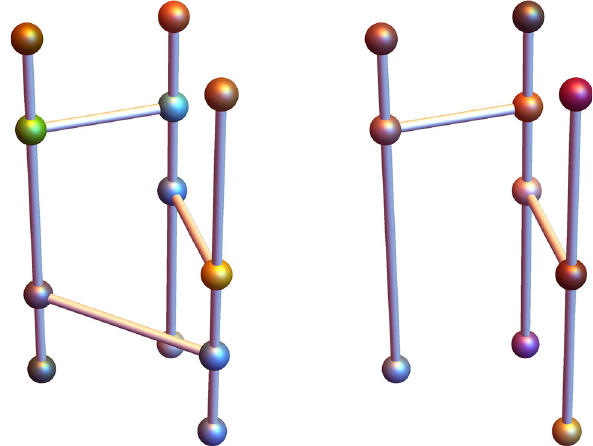
Fig. 3 A closed spin chain diagram (left) has a cylindrical symmetry and cannot be embedded on a plane. Conversely, an open spin diagram (right), has no cylindrical symmetry and is